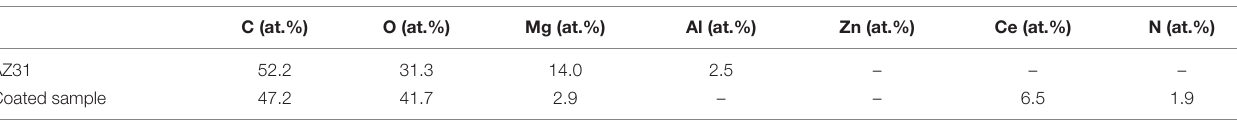
TaBle 3 | at.% ratio of oxygen species gained from peak fitting of ce3d, O1s, and c1s XPs spectra. ce3d O1s c1s species ce 3 + (at.%) ce 4 + (at.%) O1 (at.%) O2 (at.%) O3 (at.%) c–c (at.%) c–O (at.%) cOO (at.%) AZ31 –